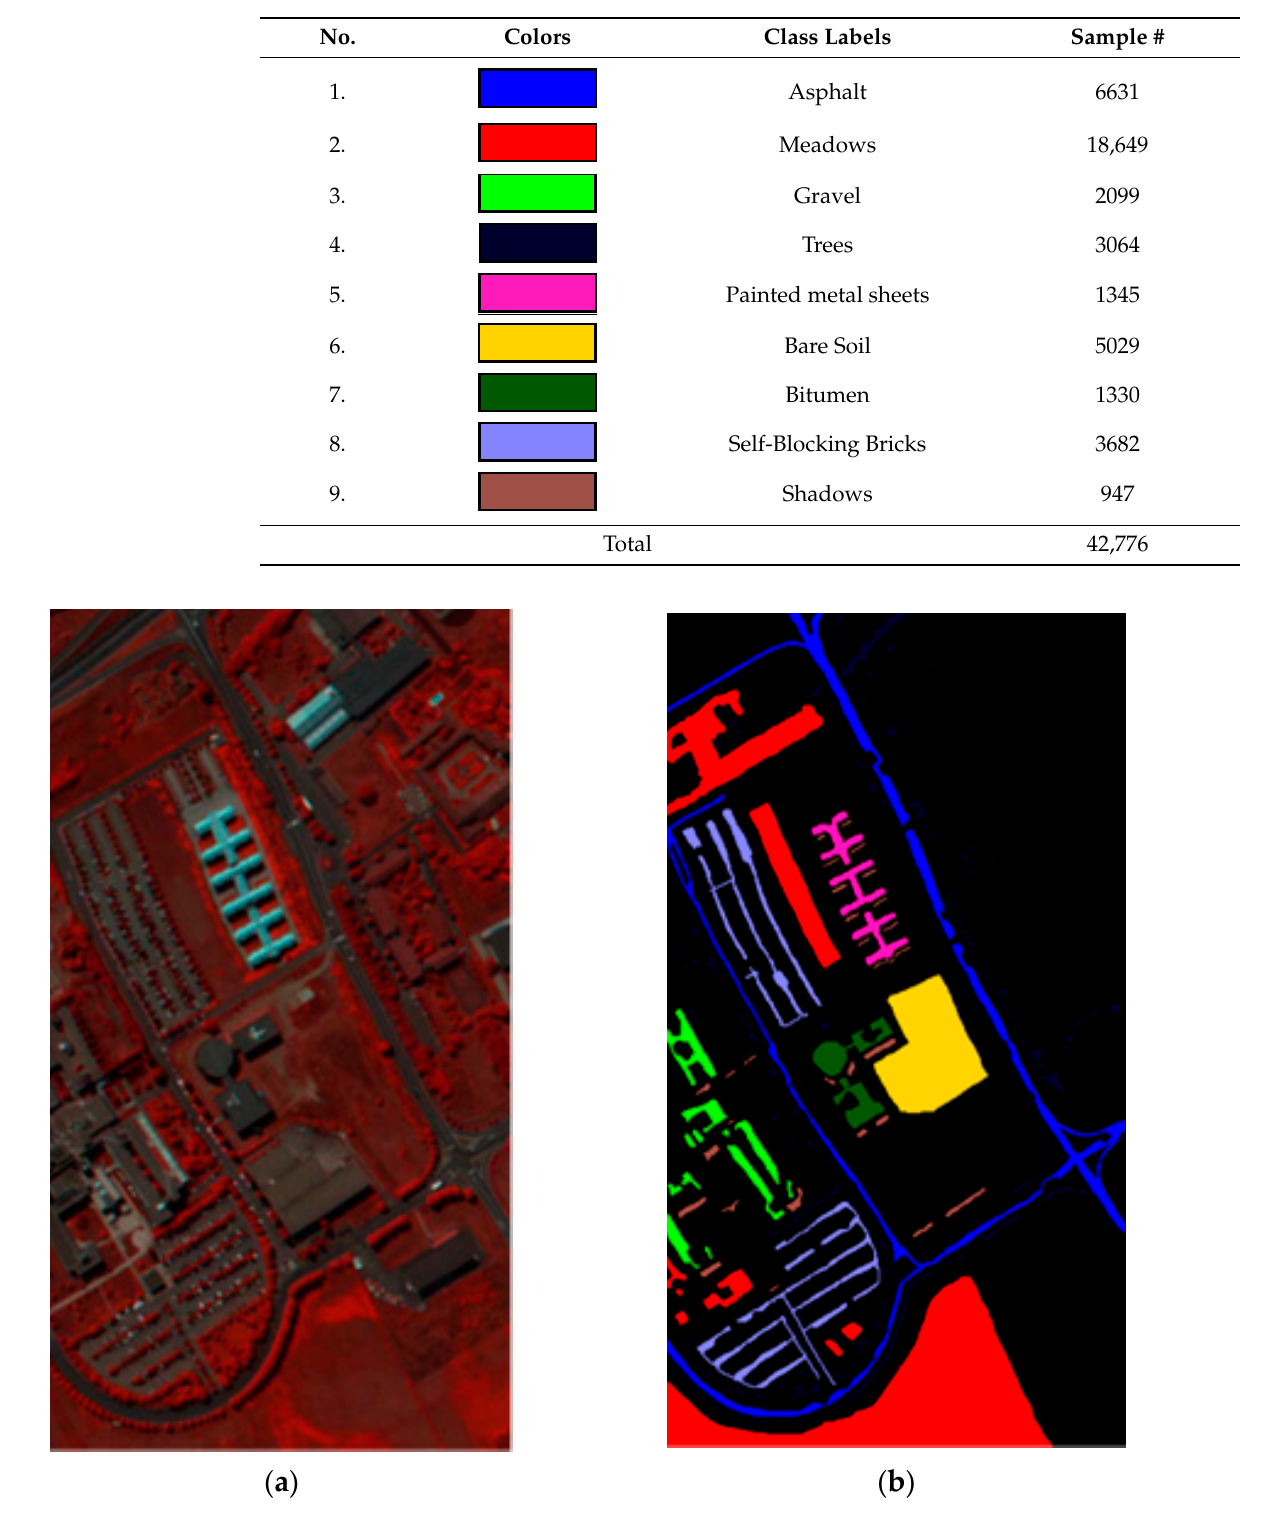
Figure 6. Dataset Pavia University: ( a ) False color image; ( b ) Class label map.